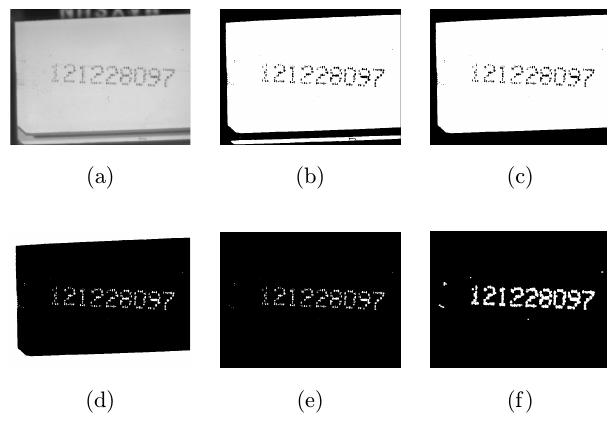
Fig. 5. Image processing procedure for DMDC feature highlighting. (a) Captured raw image, (b) binarized image by adjusted, (c) ¯ltering out the white texts, (d) the invert image of (c), (e) ¯ltering out white non-ROI and (f) highlighted DMDC by